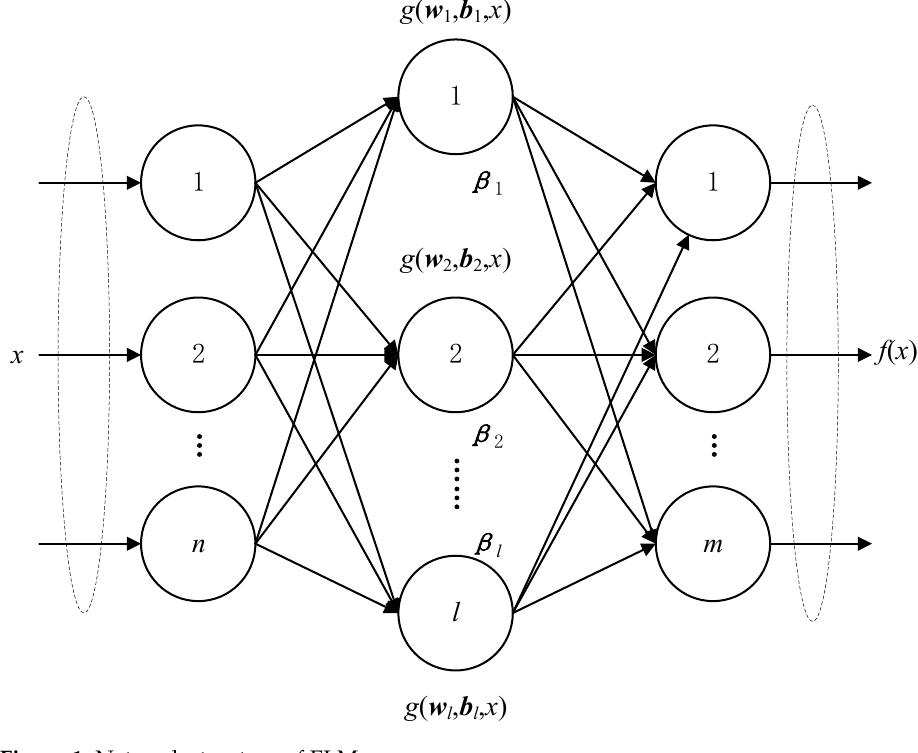
Figure 1. Network structure of ELM.